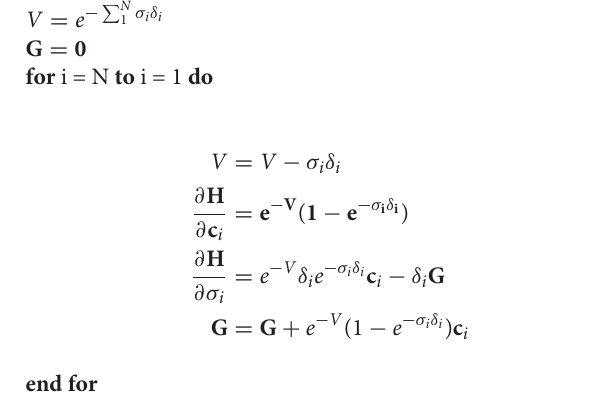
Algorithm 2 | The iterative Preconditioned Conjugate Gradient algorithm, with precondition matrix M (see Section